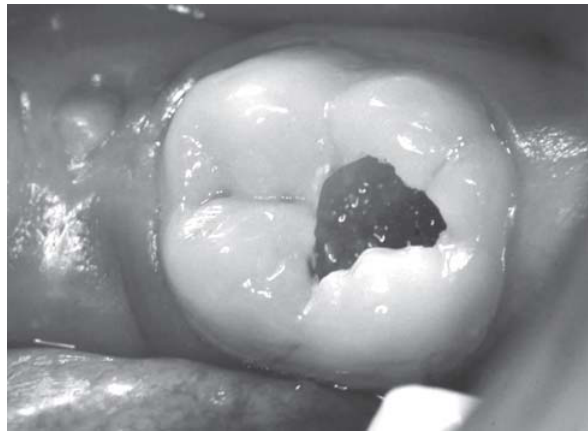
Figure 3- Restoration placed, at baseline